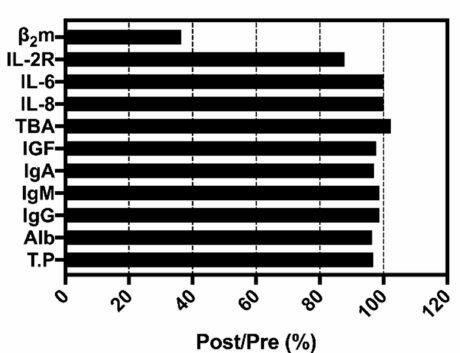
Figure 7. Changes in concentration of serum components before and after the adsorption balance in vitro. T.P, total protein; Alb, albumin; IGF, insulin-like growth factor; TBA, total bile acid; IL-6, interleukin 6; IL-8, interleukin 8; IL-2R, interleukin 2 receptor.